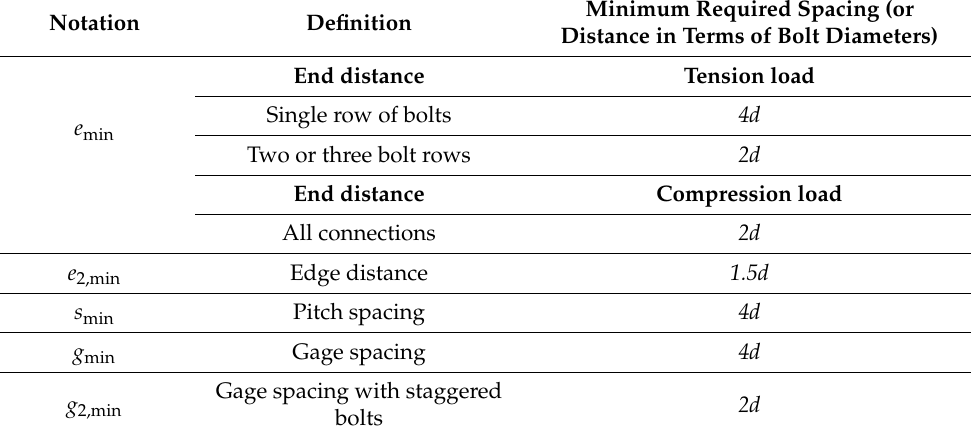
Figure 2. Failure mode of bolted connection and simplified stress distributions. ( a ) bearing, ( b ) net- tension, ( c ) shear-out, ( d ) cleavage, ( e ) net-tension ‘splitting’, and ( f ) block shear.